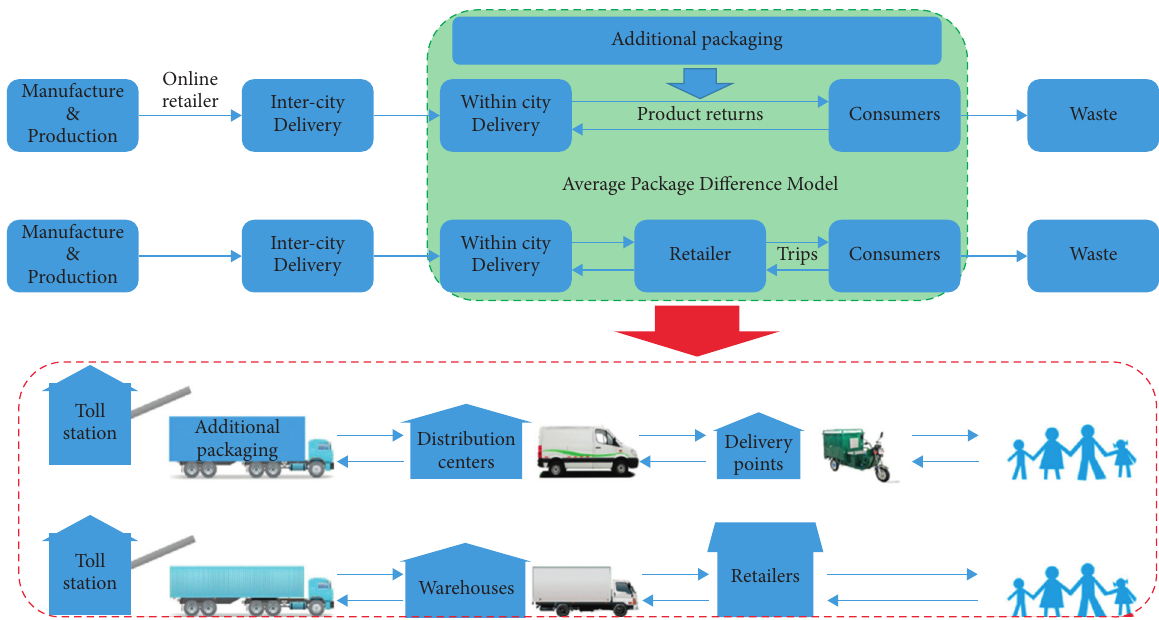
Figure 1: Schematic diagram of the theoretical framework of electronic commerce